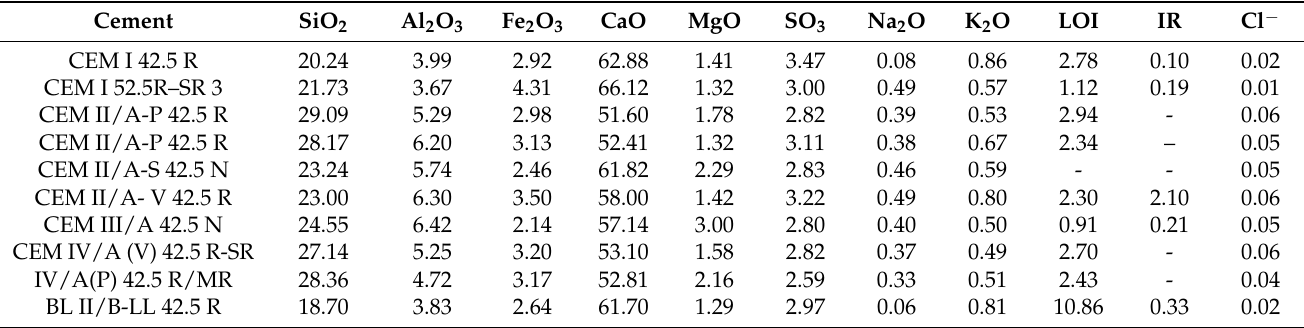
Table 1. Chemical composition of the cements used in the